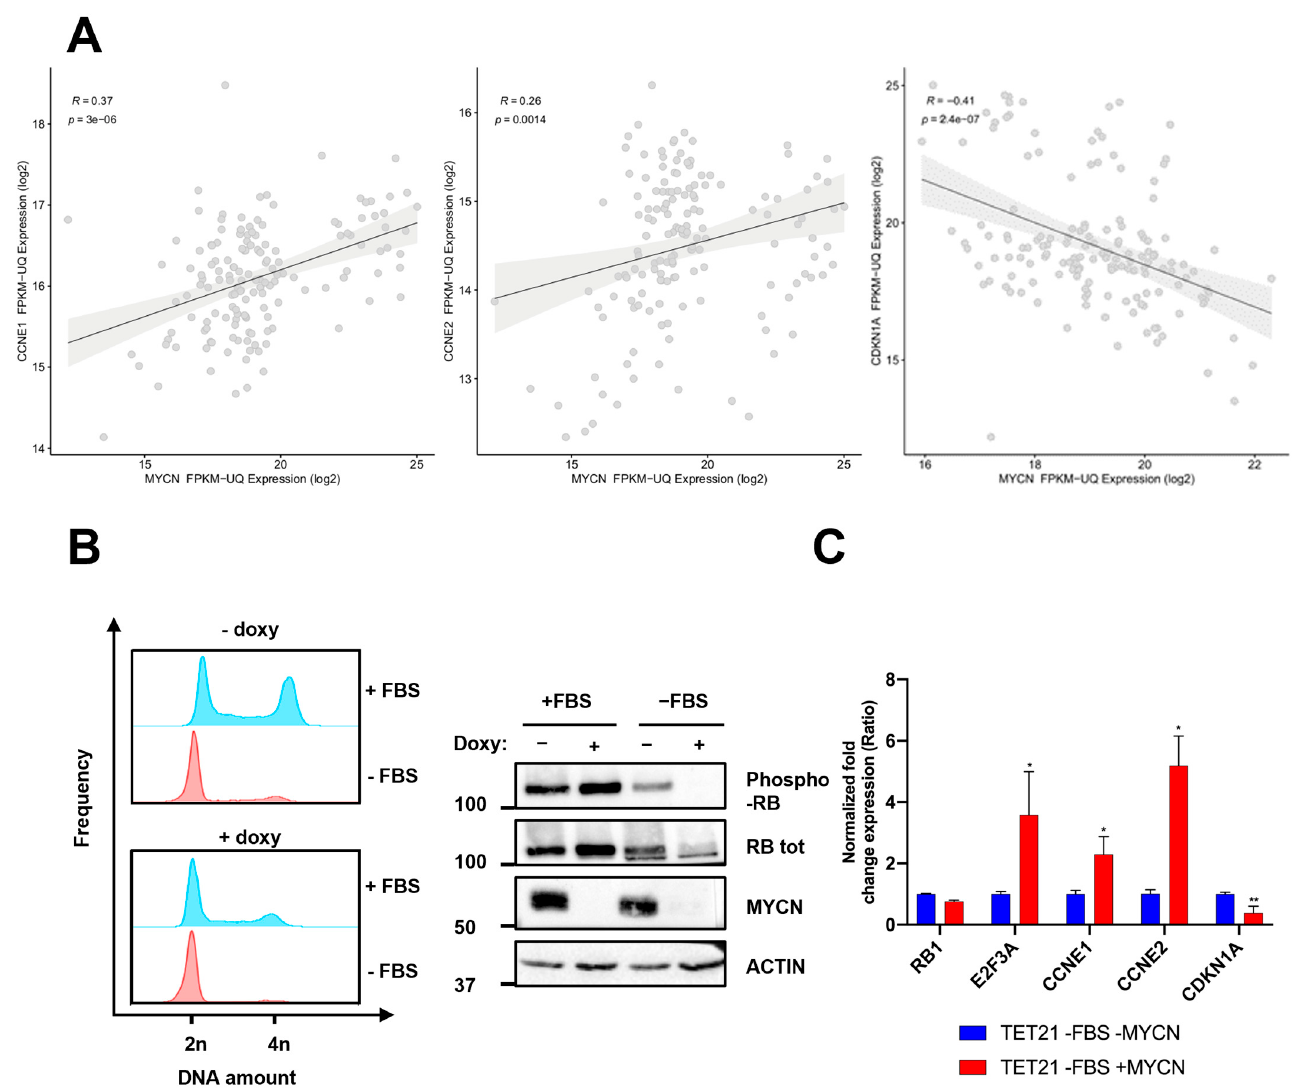
Figure 3. MYCN induces RB phosphorylation in the G1 phase. ( A ) Pearson’s correlation between MYCN and CCNE1/2 or CDKN1A in a cohort of 152 NB patients (NBL dataset). The p-value by the Mann–Whitney test is indicated. ( B ) TET21/N cells were incubated with 1µg/mL of doxycycline for 48 hours to induce MYCN KD and seeded at low density in the presence or absence of fetal bovine serum (FBS) for G0/G1 synchronization. Left: After 18 hours, cells were harvested and stained with propidium iodide for cell cycle analysis in flow cytometry. 2n and 4n indicate the relative amount of DNA. Right: Western blot of TET21/N cells treated as described. Results are representative of two (N = 2) independent experiments ( C ) qRT-PCR on G1 synchronized TET21/N cells in the presence (-MYCN) or absence (+MYCN) of doxycycline. Data were normalized using the TBP housekeeping gene. The experiment was performed in triplicate (N = 3). Data were plotted as the mean ± SD. Statistical analyses were performed using two-way ANOVA. Error bars represent SD. *, **, indicated p < 0.05, 0.001, respectively. 2.4. Endogenous RB Replacement with RB Δ CDK Triggers Proliferation Arrest in MYCN- Amplified NB Cell Lines To further corroborate the hypothesis that MYCN can induce RB phosphorylation and its subsequent inactivation, we assessed the cell proliferation phenotype of MYCN - amplified cells in which endogenous RB was replaced with its hyperactive mutant (RB Δ CDK ). For this purpose, we engineered CHP-134 and kelly NB MYCN amplified cell